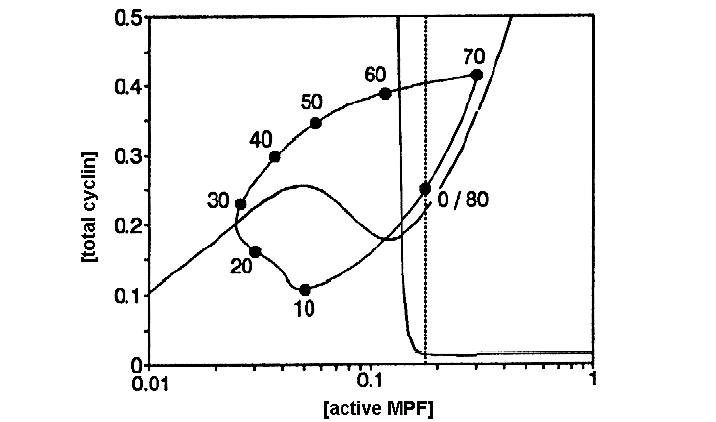
Figure 4. A limit cycle attractor governs the cell cycle. The cell cycle is controlled by a dynamical structure called ―limit cycle‖ which is a closed orbit corresponding to the oscillations with a period of 80 minutes. The numbers along the limit cycle represent time in minutes after exit from mitosis. Reproduced with permission from the Company of Biologists Ltd.